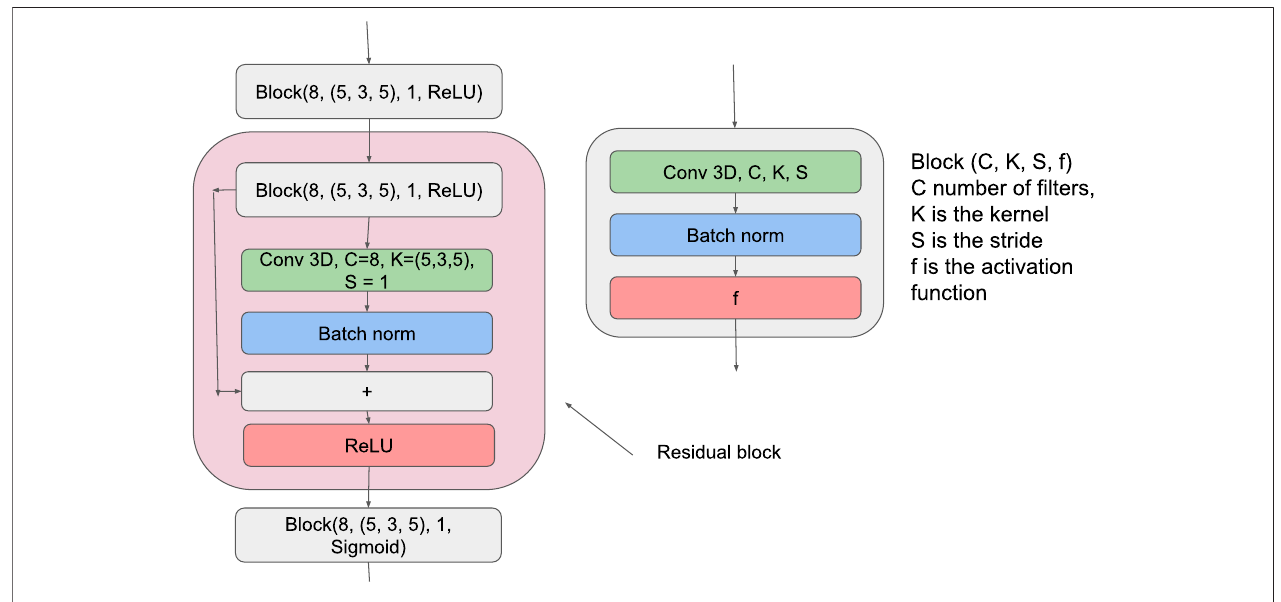
FIGURE 4 | Schematic representation of the CNN architecture employed in this